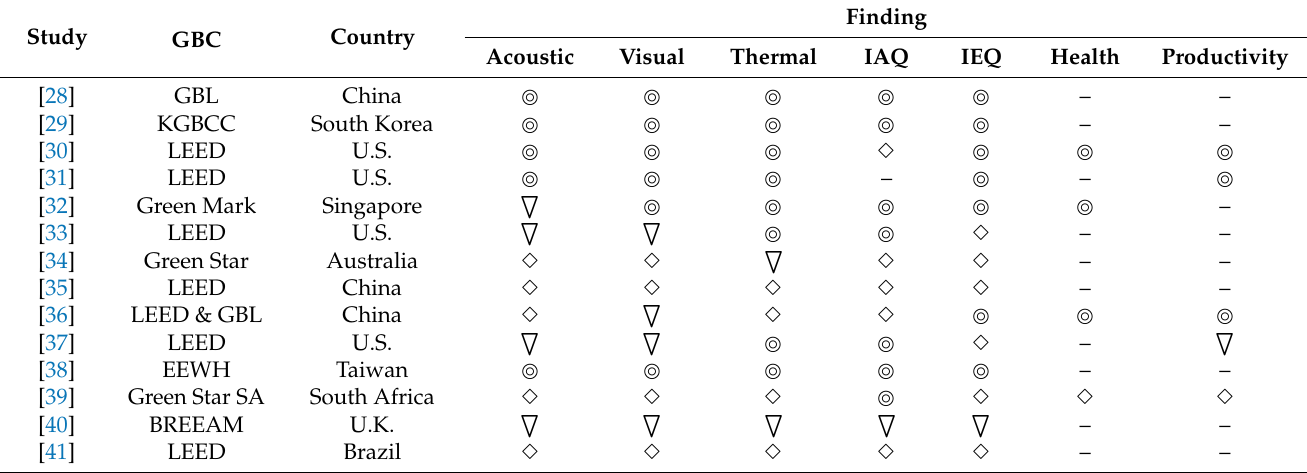
Table 1. Previous studies comparing the performance of GBs and